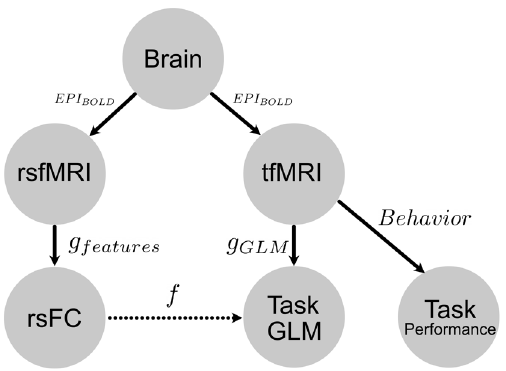
Figure 1. A conceptual model of the problem setup and goal. Both rsfMRI and tfMRI measuresments are acquired using BOLD echo planar imaging ( EPI BOLD ) by the Human Connectome Project scanners and acquisition protocols. These reconstructed and processed images from a single subject are mapped by some encoding model: either resting-state functional connectivity features (rsFC) by function g features or tfMRI data mapped to a z-statistical map summarizing task activation by function g GLM . Function f is the model mapping rsfMRI features to task maps. Our goal is to find optimal models g features and f that give the highest performing whole-cortex prediction of task GLM maps (see “Evaluation” section for metrics describing how model performance score is measured). Additionally, activity during the acquisition of tfMRI generates some observed behavior commited during the task. Whether the relative dependence between rsfMRI and tfMRI tell us anything about task behavior is an important question we sought to answer through improving these models.